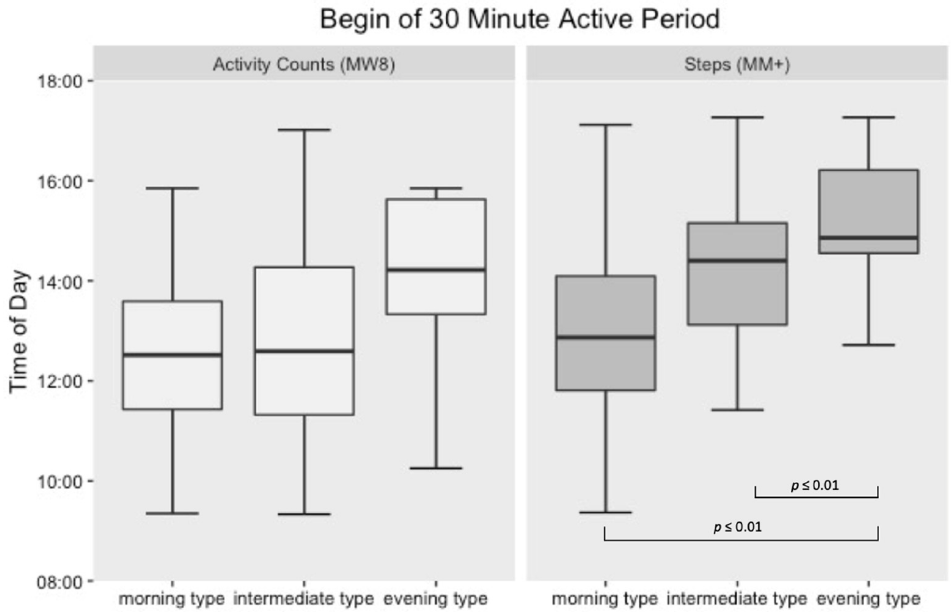
Figure 2. Box-plot illustration of 30-min active periods beginnings in relation to the subjectively rated chronotypes.